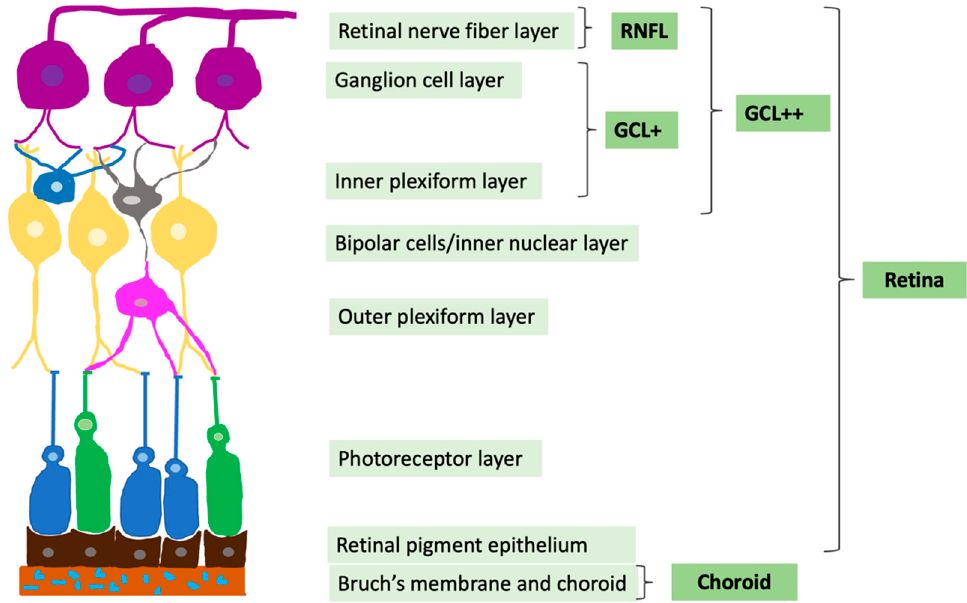
Figure 2. Representation of retinal layers evaluated by DRI OCT Triton. Adaptation from Vilades E. et al. 2020 [35].